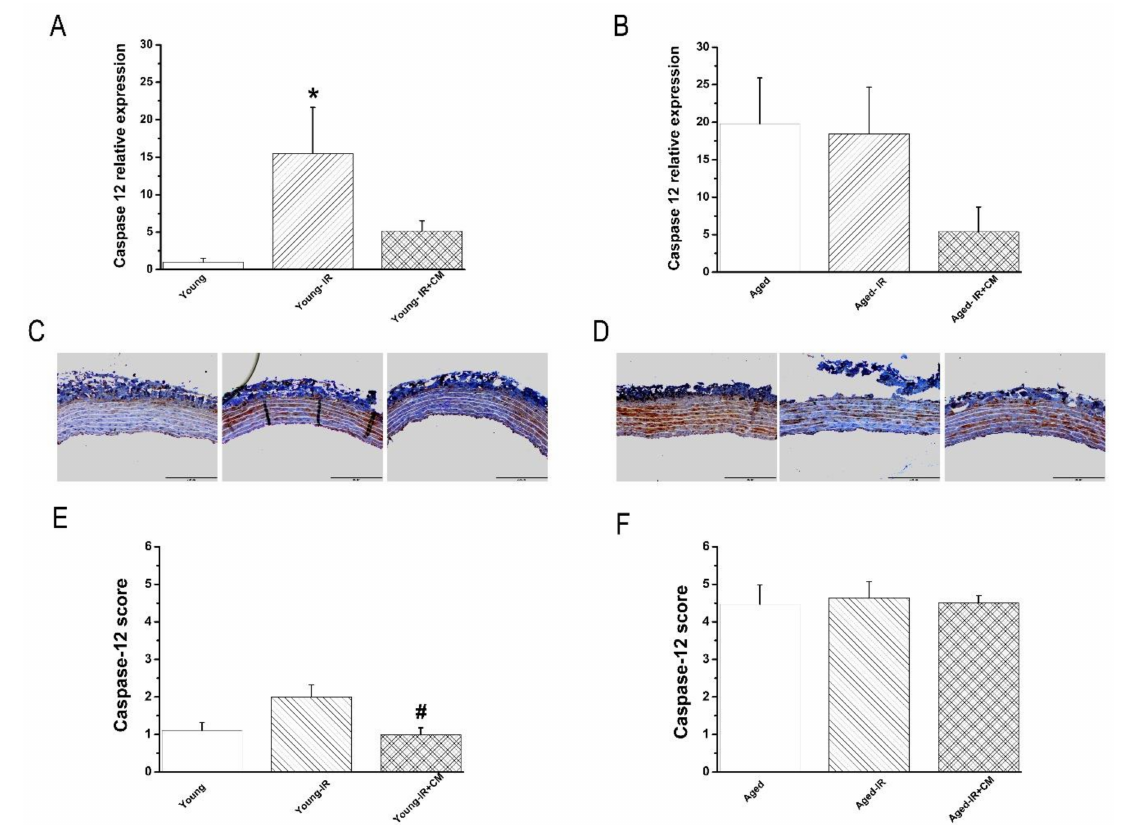
Figure 5. Effects of conditioned medium (CM) from bone marrow-derived mesenchymal stem cells against is- chemia/reperfusion (IR) injury on caspase-12 expression. ( A , B ) caspase-12 mRNA expression and ( C , D ) representative images of caspase-12 immunohistochemical staining (brown staining, × 20, bar = 200 µ m) followed by ( E , F ) semi-quantitative analysis in young and 15-month-old rats. Data are represented as mean ± SEM. * p < 0.05 vs. young, # p < 0.05 vs.